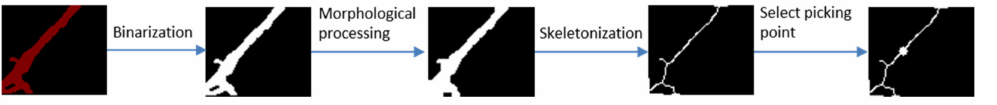
Figure 5. Post-processing algorithm of semantic segmentation image of litchi main stem